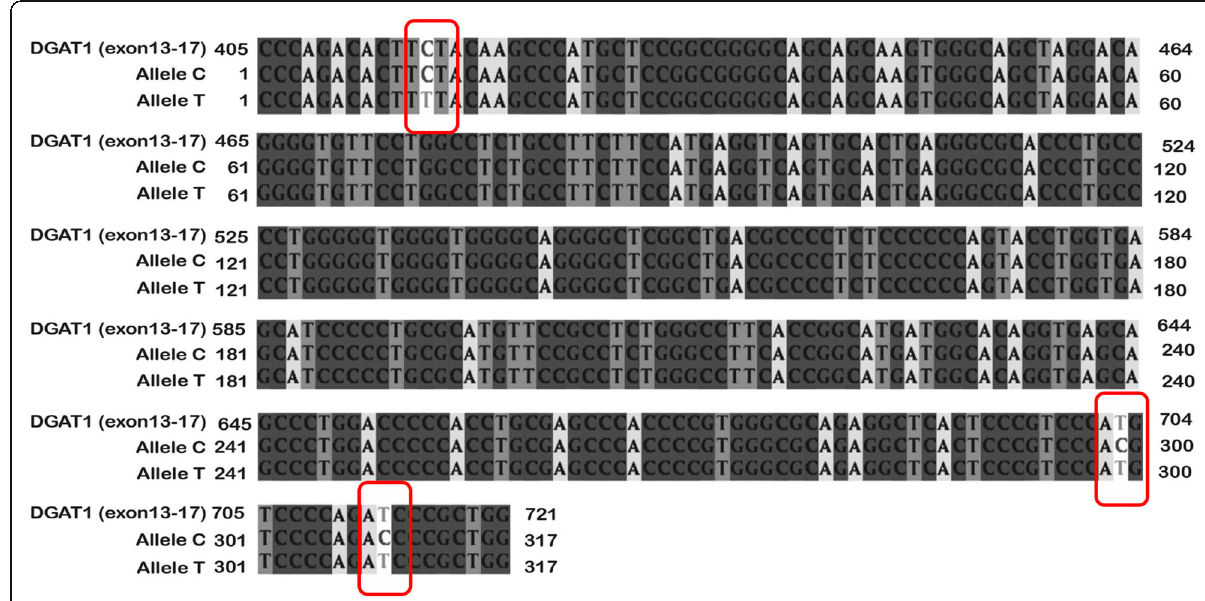
Fig. 3 Alignment of DGAT1 sequence in Zaraibi goats and their corresponding region from